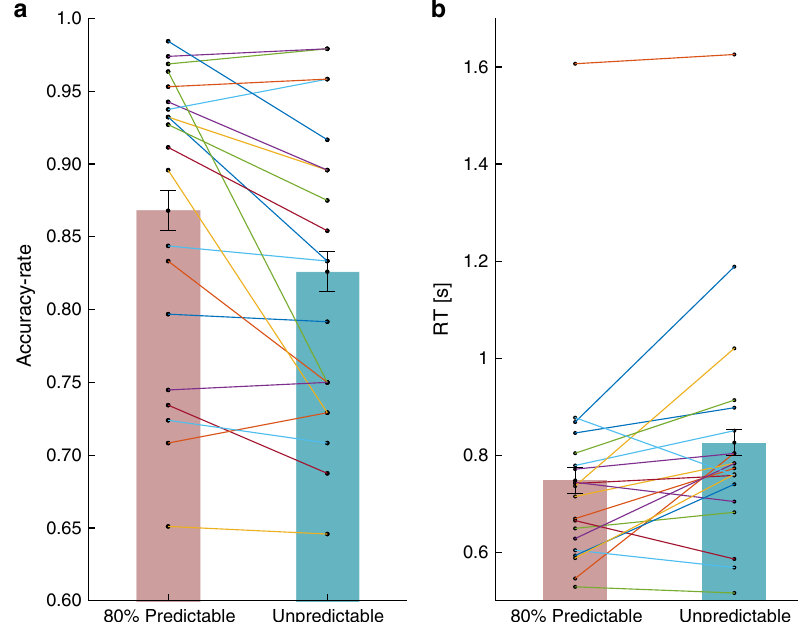
Fig. 7 Experiment 2: Accuracy-rates and reaction times (RTs) in the 1 second foreperiod. a Accuracy-rates in predictable (pink bars) and unpredictable (turquoise bars) conditions. N = 20 participants. b Reaction times in predictable (pink bars) and unpredictable (turquoise bars) conditions. Error bars denote ±1 standard error of the mean, corrected for within-subjects variability 60 . The colored connecting lines represents individual participants. N = 20 participants. Source data are provided as a Source Data fi